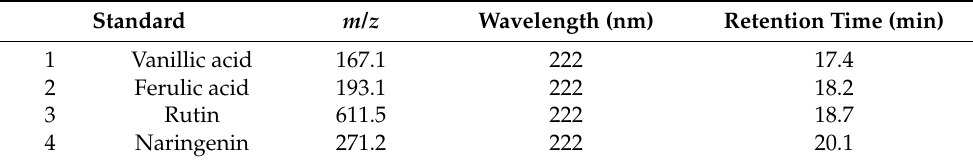
Table 4. Wavelengths of quantification and retention times related to the investigated phenolic compounds.